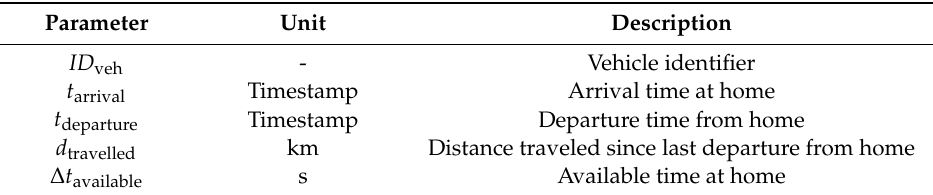
Table 1. Vehicle availability characterizing parameters.